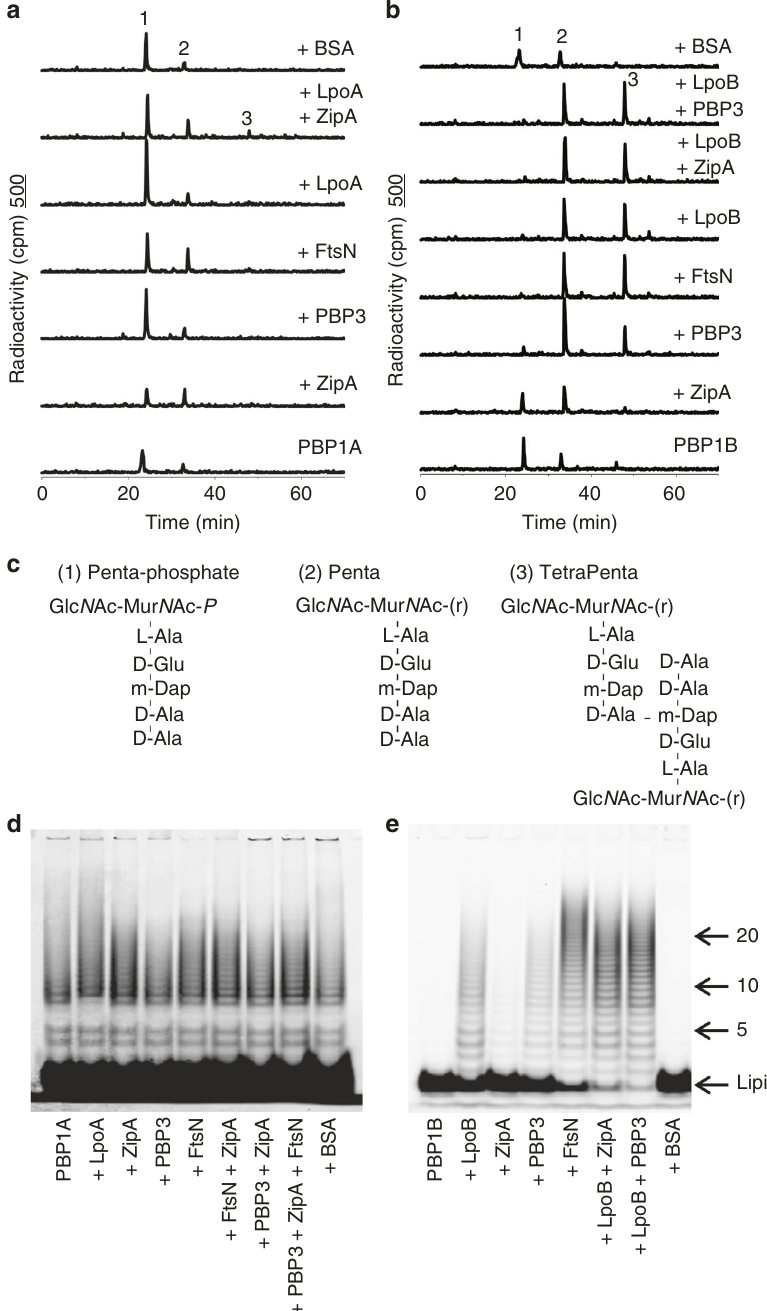
Fig. 4 Stimulation of PBP1A and PBP1B activities at low concentration. a , b Representative HPLC chromatograms of PBP1A ( a ) and PBP1B ( b ) in vitro PG synthesis reactions in the presence of the proteins indicated, using radioactive lipid II as substrate. The synthesised PG was digested with cellosyl, reduced with sodium borohydride and analysed by HPLC. Peak 1 is generated from glycan chain ends and unreacted lipid II, peak 2 is a GTase product and peak 3 is a GTase/TPase product. ( c ) Structures of the main products of the in vitro synthesis reactions. d , e SDS-PAGE analysis of glycan chains synthesised by PBP1A ( d ) and PBP1B ( e ) GTase activity at low concentration. Reactions were incubated at 37 °C for 1 h, using a mixture of unlabelled and ATTO(550)- labelled lipid II as substrate, in the presence of the indicated interacting proteins. The numbers refer to disaccharide units. The contrast of the image in panel d was increased due to the low signal